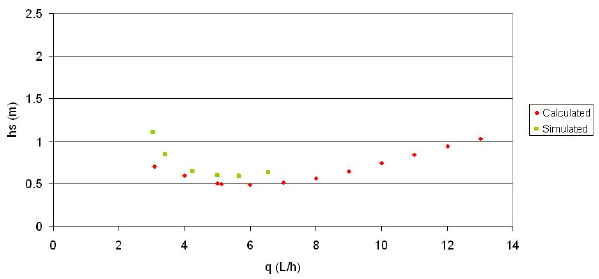
Fig. 8. Evolution of CV q as a function of discharge for both simu- lation